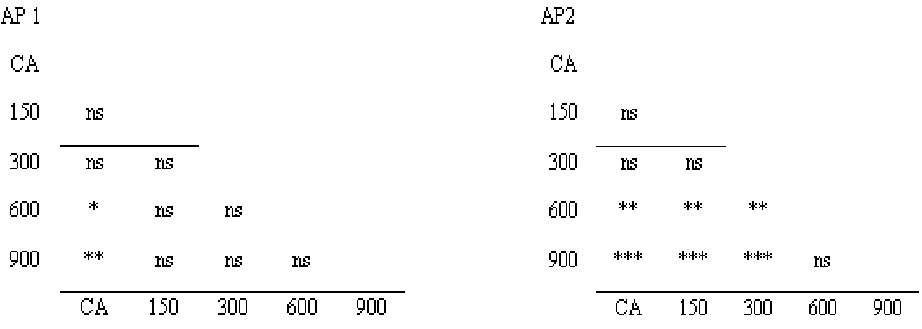
Figure 5. UPGMA dendrogram based on two anal papillae: 900-150 doses of neomycin (150-900 mg/L), CA – the control group .